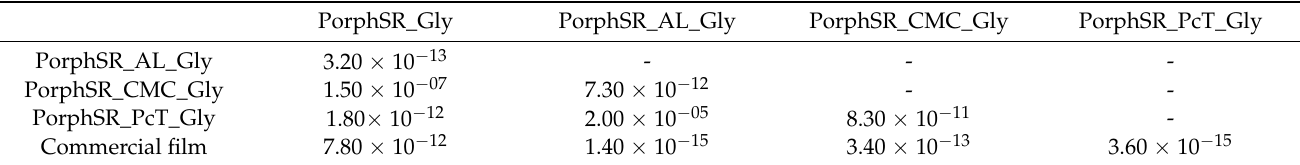
Table A3. Bonferroni pairwise comparison p -values for the different water vapor permeabilities.